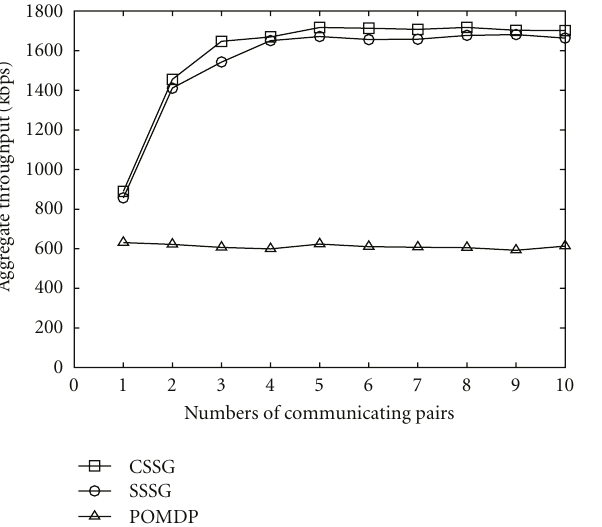
Figure 8: Aggregate throughput; Channel 1: β = 0.8; Channel 2: β = 1.0; Channel 3: β = 1.0.